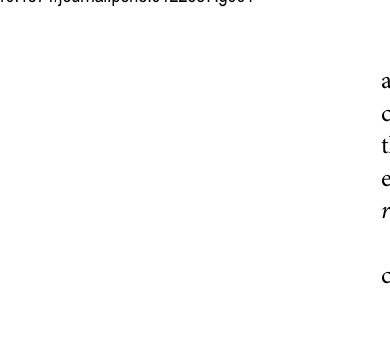
Fig 1. PRISMA flow chart. PRISMA flowchart detailing selection of studies included in meta-analysis.